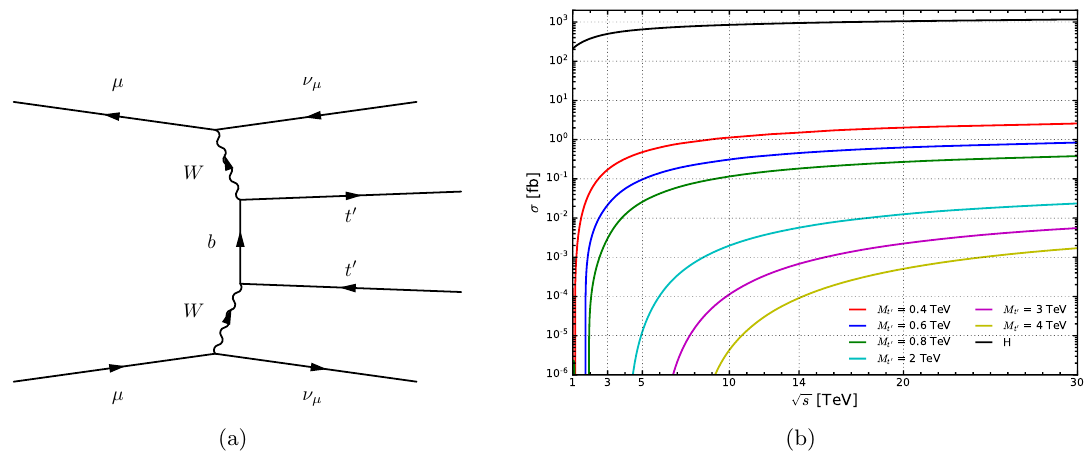
Figure 15 . Same as (cid:12)gure 9 but for the VLQ pair t 0 t 0 , as described by equation (6.26). Here, M is the mass of the VLQ, V 4 i is model-dependent and accounts for any t 0 L=R